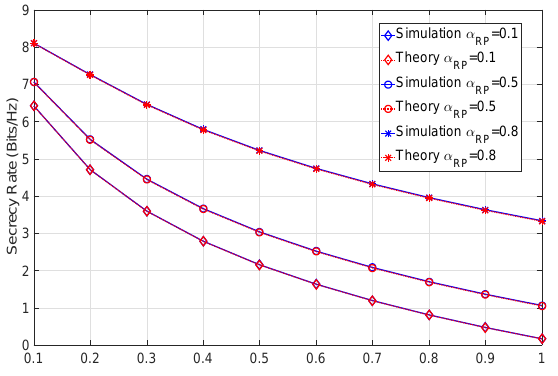
Figure 11. Secrecy rate of the system for various ray power ratios with β N = ∞ .